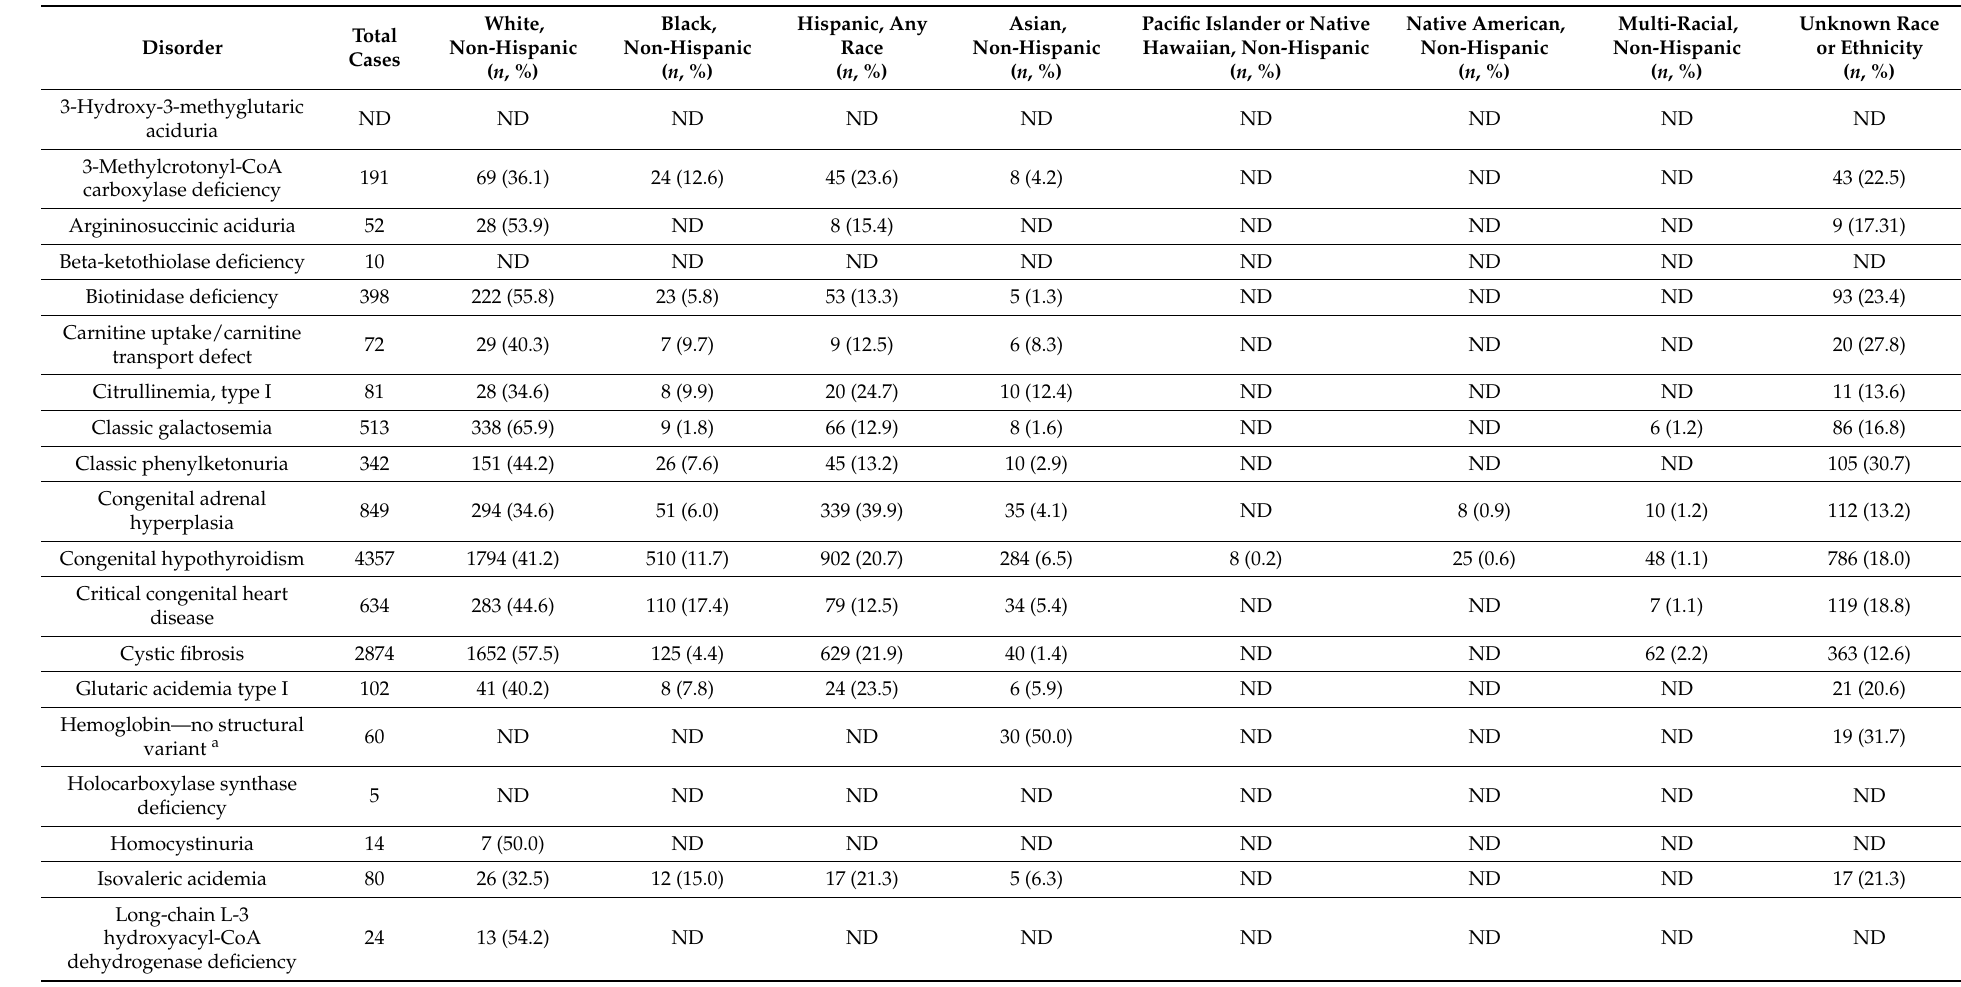
Table 3. Racial/ethnic distribution of patients with newborn screening disorders from 25 states ( n = 16,010